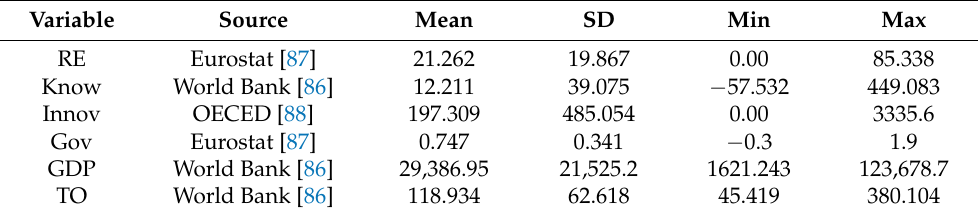
Table 1. Descriptive statistics of the analyzed panel